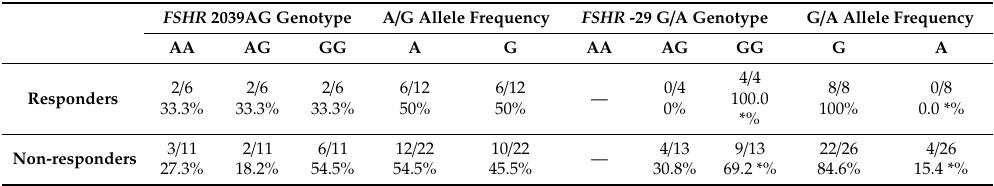
Table 5. Distribution of the FSHR 2039A / G and FSHR G / A genotype in infertile responder and non-responder patients to FSH